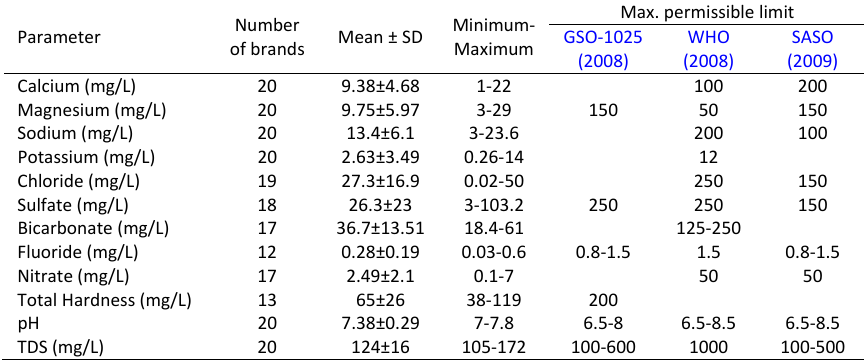
Table 1: Comparison of Omani bottled water quality with standards Parameter